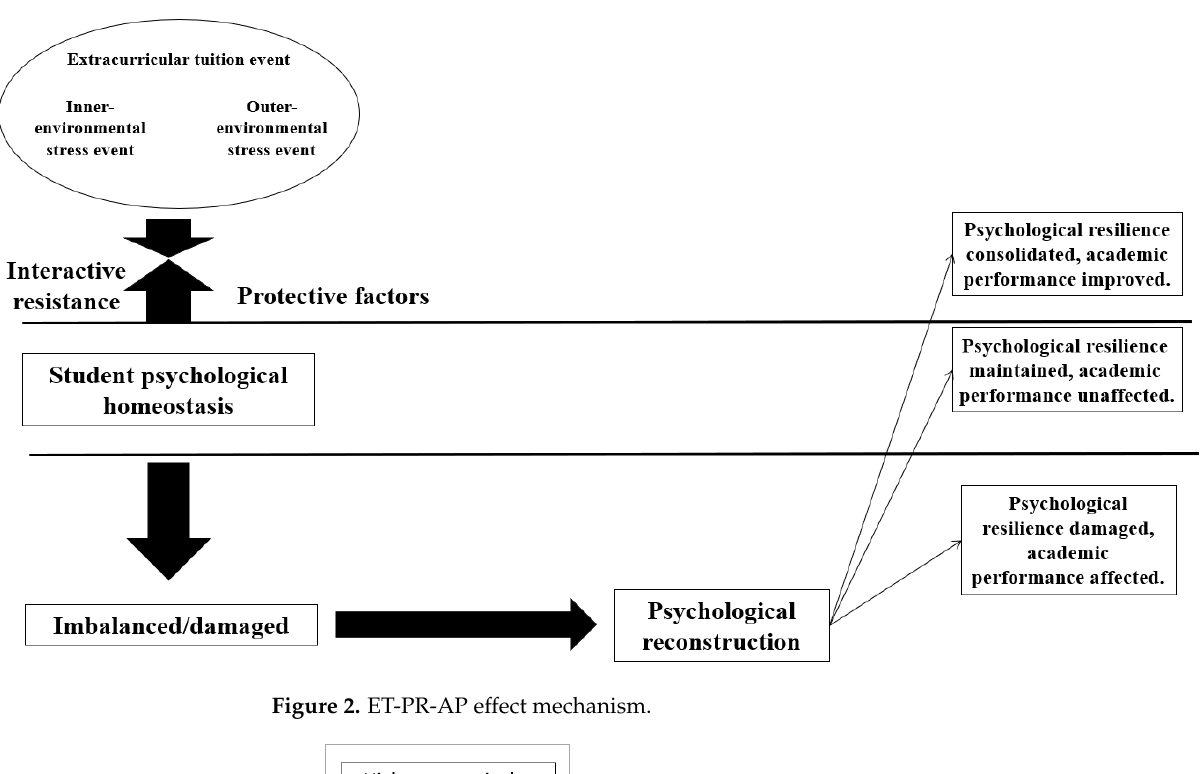
Figure 2. ET-PR-AP effect mechanism.